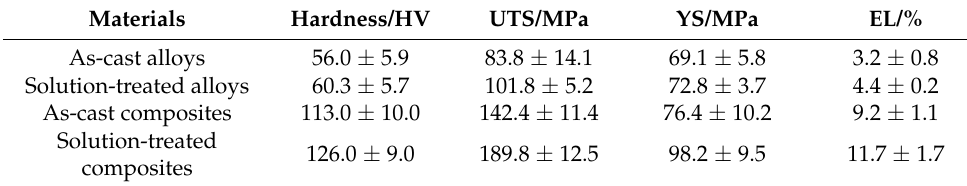
Figure 9. Mechanical properties of the alloys and the composites in as-cast state and after solution treatment. Table 1. Mechanical properties of the alloys and the composites before and the after the solution treatment.